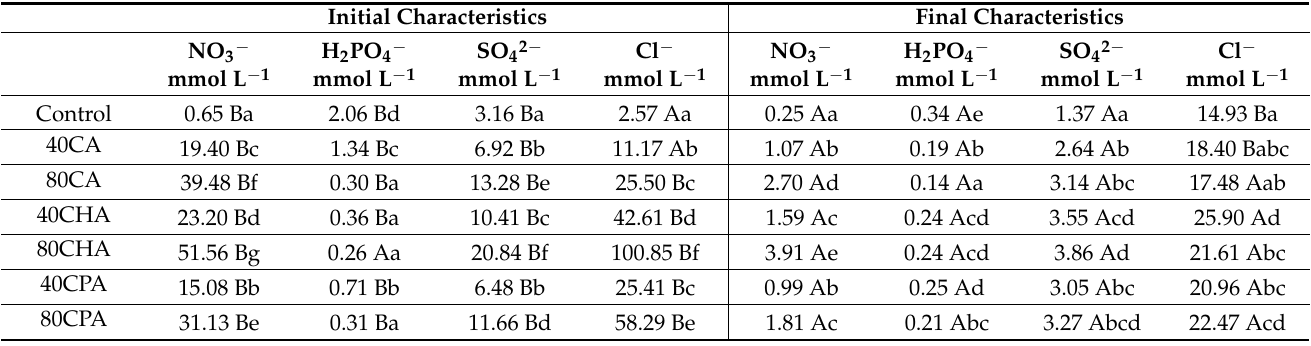
Table 4. Effects of different treatments on the initial and final anion concentrations in paste saturated extracts of the substrates (NO 3 − ; H 2 PO 4 − ; SO 42 − ; Cl −